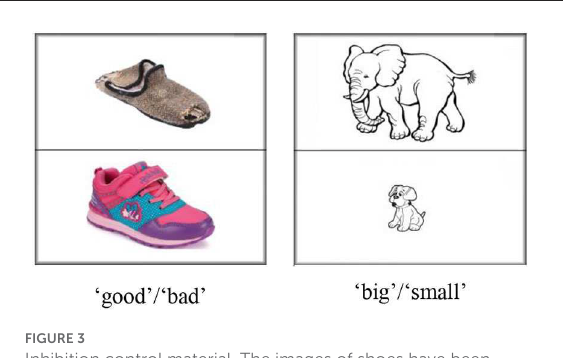
FIGURE3 Inhibition control material. The images of shoes have been reproduced from